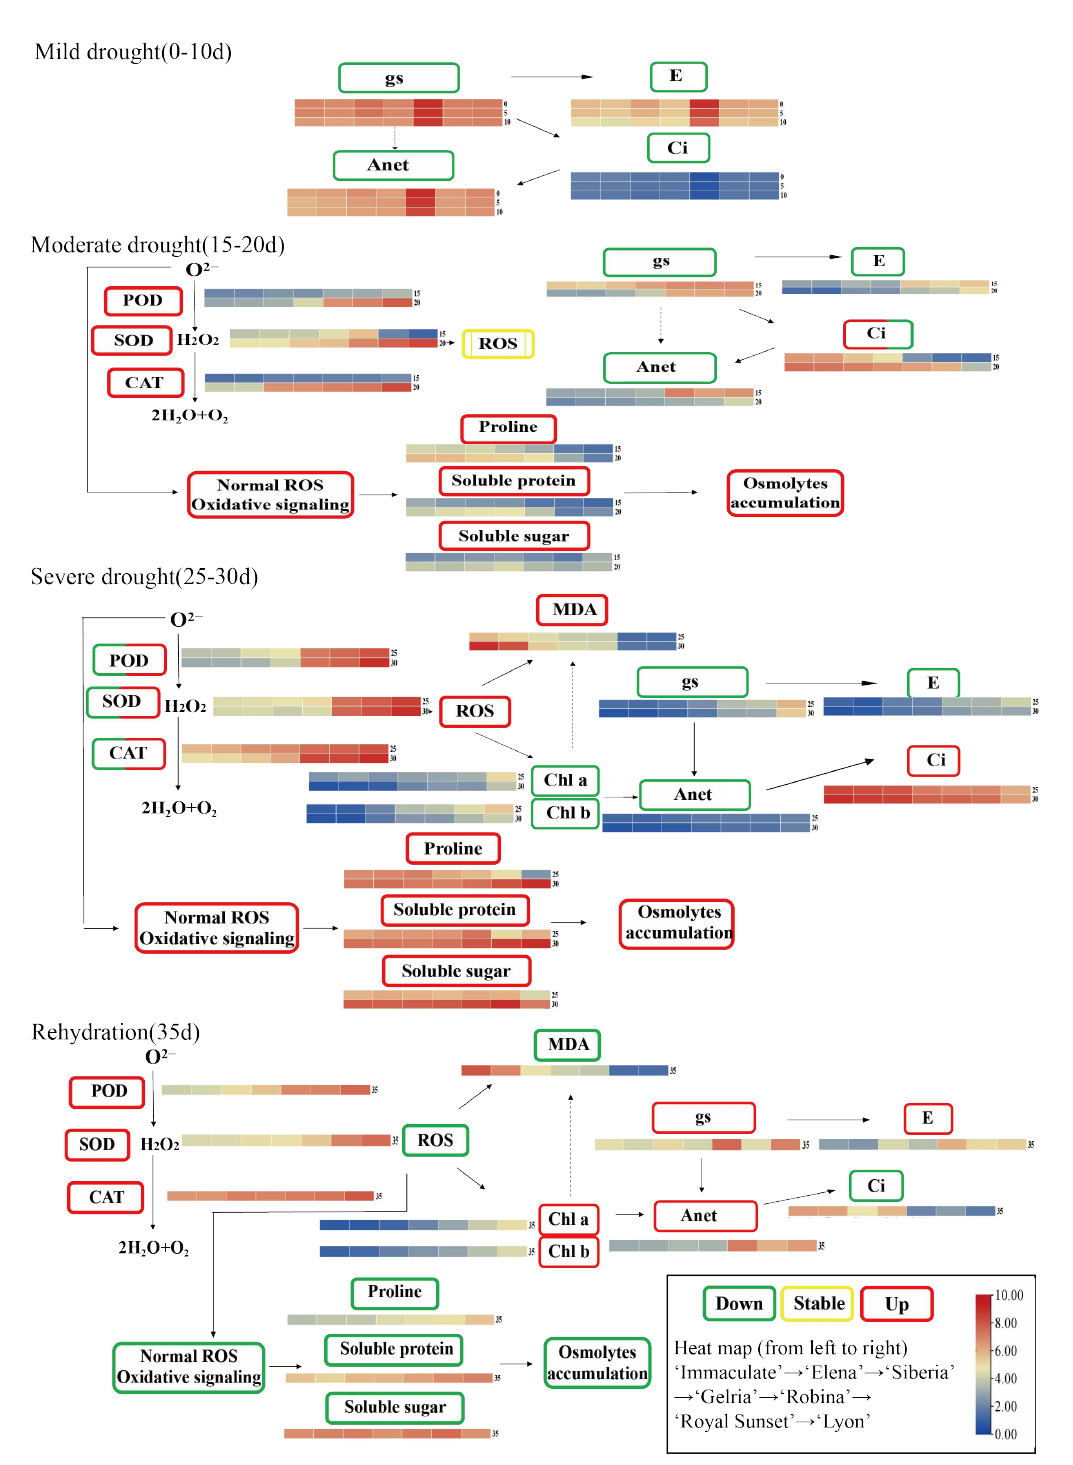
Figure 10. Physiological adaptation model of the lily under drought stress and rehydration. The green box indicates that the index decreases, the red box indicates that the index increases, and the yellow box indicates that the index does not change. gs, stomatal conductance; Ci, intercellular CO 2 concentration; Anet, net photosynthetic rate; E, transpiration; SOD, superoxide dismutase; POD, peroxidase; CAT, catalase; MDA, malondialdehyde; ROS, reactive oxygen species; Chl a, chlorophyll a; Chl b, chlorophyll b. The heatmap reflects the index changes of the seven lily varieties, and the drought resistance gradually increases from left to right, followed by ‘Immaculate’, ‘Elena’, ‘Siberia’, ‘Gelria’, ‘Robina’, ‘Royal Sunset’,